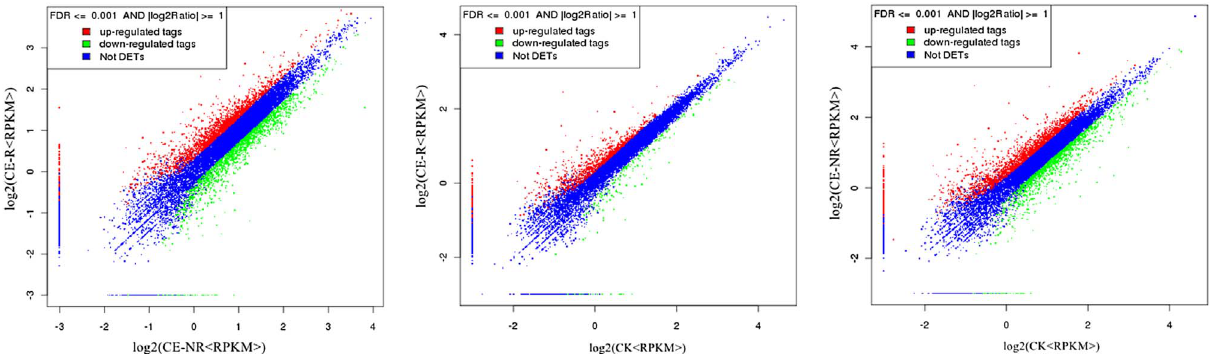
Figure 2. Scatter chart of differential expression genes between groups. Figure 2A shows differential expression genes between the CE-R and CE-NR groups. Figure 2B shows differential expression genes between the CE-R and CK groups. Figure 2C shows differential expression genes between the CE-NR and CK groups. X -axis and Y -axis presents two samples log2 value of gene expression, and the expression was calculated using the RPKM method (reads per kilobase transcriptome per million mapped reads) as shown in section “ Materials and methods ” , red (up) and green (down) dots mean the gene has signi fi cant differences (FDR (cid:3) 0.001, two fold difference), and the blue dot means no signi fi cant